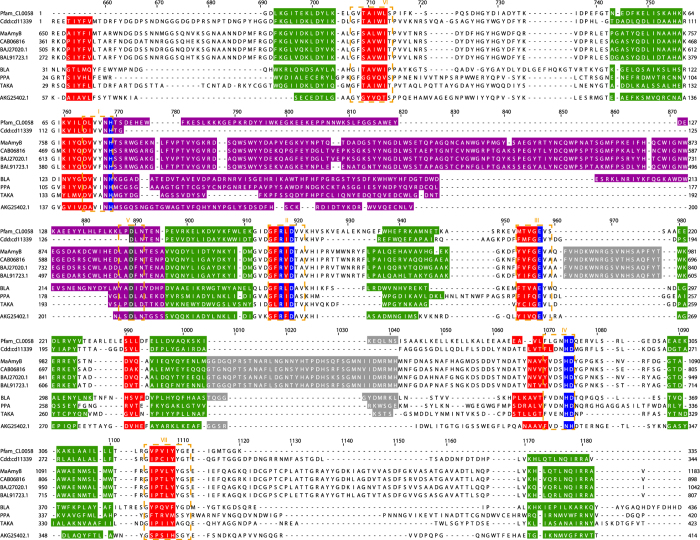
Alignment of the AB-regions of MaAmyB and 3 additional GH13_42 members (CAB06816, BAJ27020.1, BAL91723.1), Pfam CL0058 and CDD CD11339 from the databases and 4 characterized α-amylases: Pig pancreatic α-amylase (PPA) (P00690.3), Taka amylase A from Aspergillus oryzae (TAKA) (P0C1B4.1), Bacillus licheniformis α-amylase (BLA) (P06278.1) and MaAmyA (AKG25402.1).The B-region is indicated in purple, the two insertions in the A-region of GH13_42 are indicated in grey. The α-helices of the (β/α)8 barrel are indicated in green, β-sheets in red. Conserved Ca2+ binding aspartate residues are indicated in dark grey23. Other conserved residues are indicated in blue23. The 7 conserved regions of α-amylases are indicated with dashed orange lines and roman numbers23. Amino acid numbering as in MaAmyB.